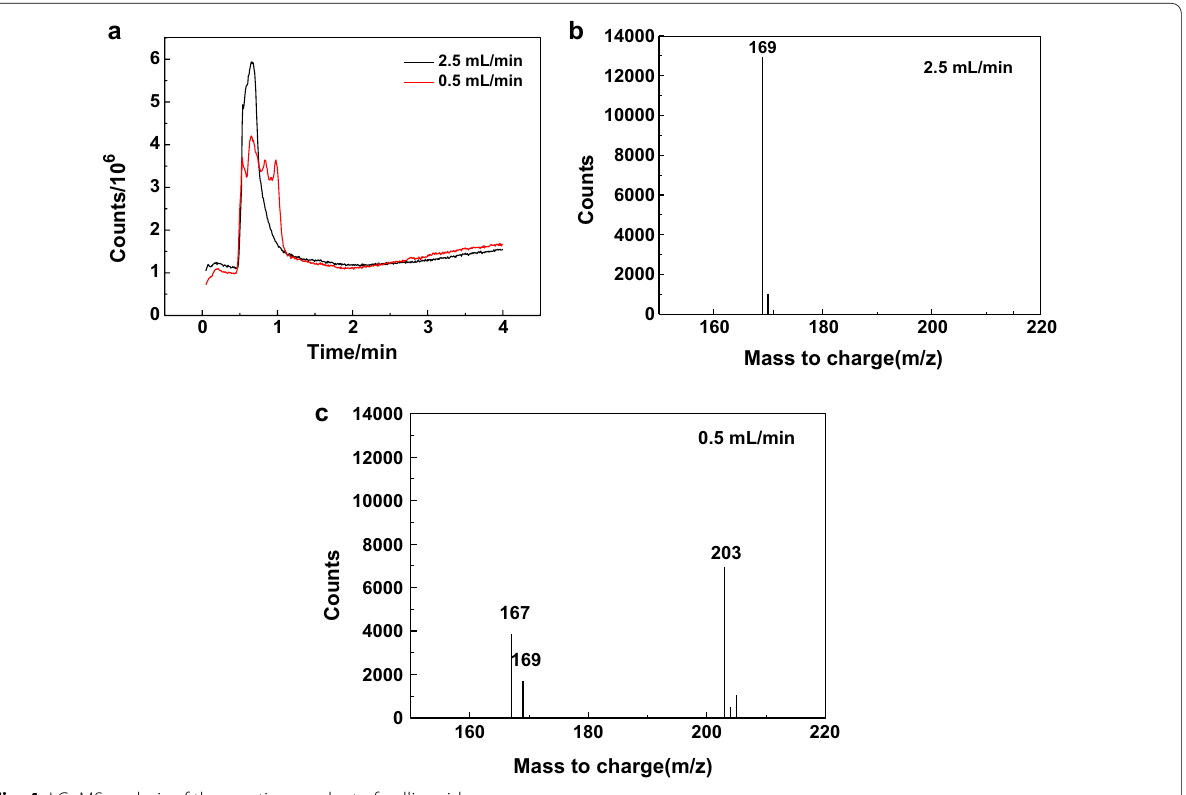
Fig. 4 LC–MS analysis of the reaction product of gallic